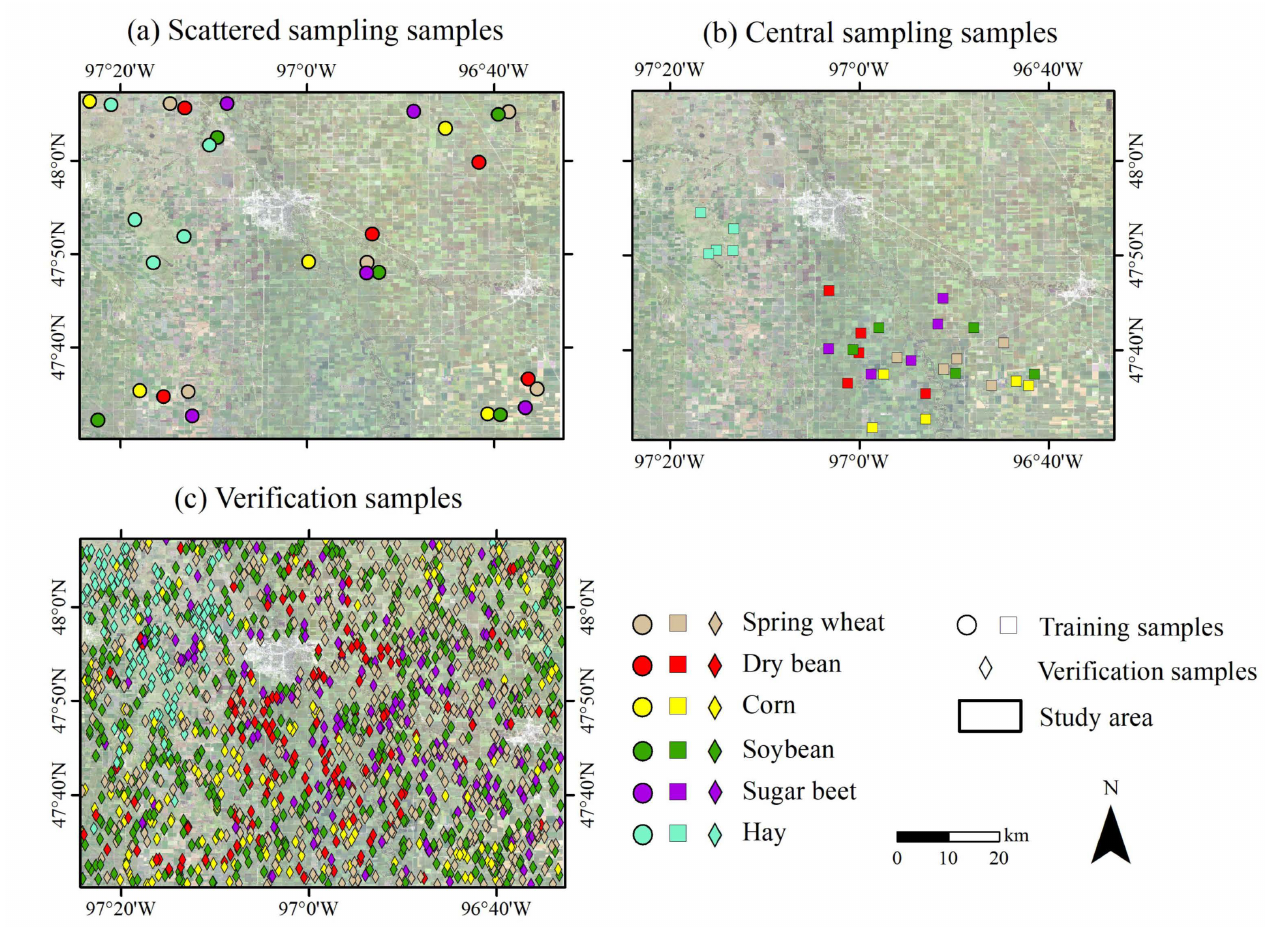
Figure 2. Spatialdistributionoftrainingsamplesusingscattered( a )andcentralsamplingstrategies ( b ) and verification samples ( c